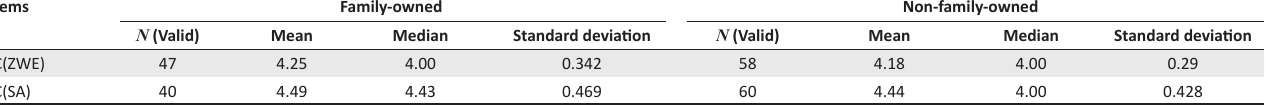
TABLE 1: Managerial interpersonal competencies in Zimbabwean and South African small and medium-sized enterprises. Items